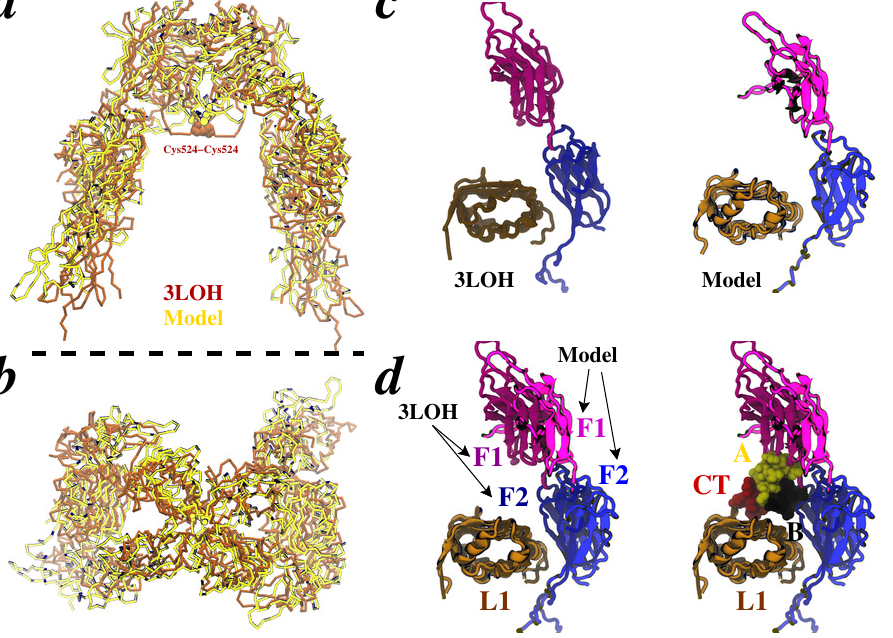
Figure 6. Comparison of apo-IR ∆ β and MDFF-generated model. ( a,b ) Overlay of apo-IR crystal structure (brown; PDB code 3LOH) and our MDFF-generated model (yellow). Front ( a ) and top ( b ) views are rendered. The dotted black line represents the location of membrane. Insulin and α CT are omitted. ( c,d ) Displacement of the F1-F2 pair is highlighted. Conformation of the L1-F1-F2 fragment from the apo-IR crystal structure (left panel in c ) and our model (right panel in c ) of insulin/IR ∆ β complex; structures were aligned based upon C -atoms of the L1 domain. Overlay of panels displayed in c is also shown without α (left panel in d ) and with (right panel in d ) insulin/ α CT (space-filling),